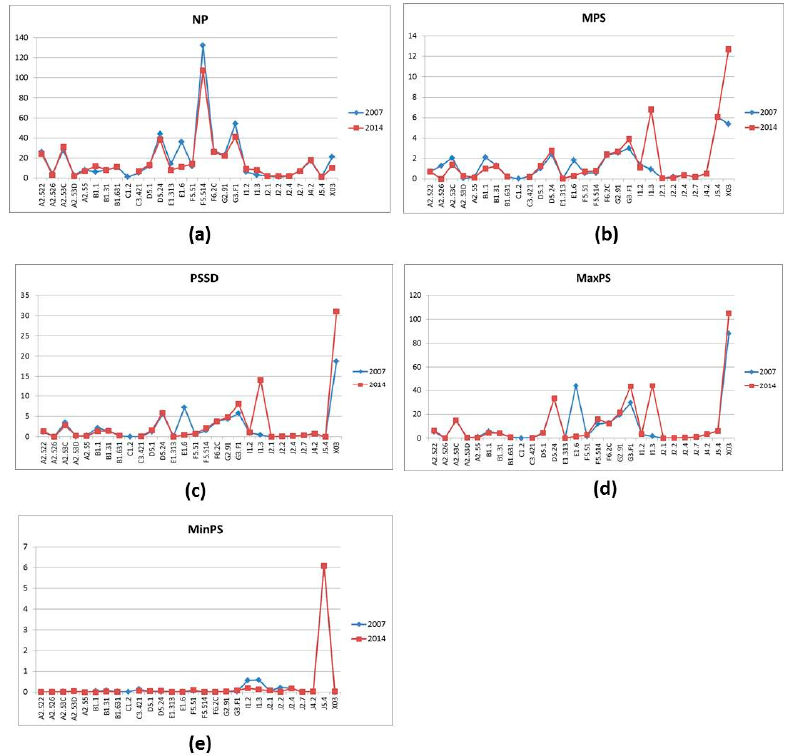
Figure 14. Diagrams comparing: ( a ) NP, number of patches; ( b ) MPS, mean patch size; ( c ) PSSD, patch size standard deviation; ( d ) MaxPS, max patch size; and ( e ) MinPS, min patch size at the CE site in 2007 and